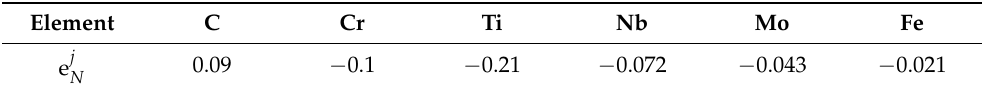
Table 4. Interaction coefficient of the typical elements in the superalloy at 1873 K. Adapted from ref. [29–32].